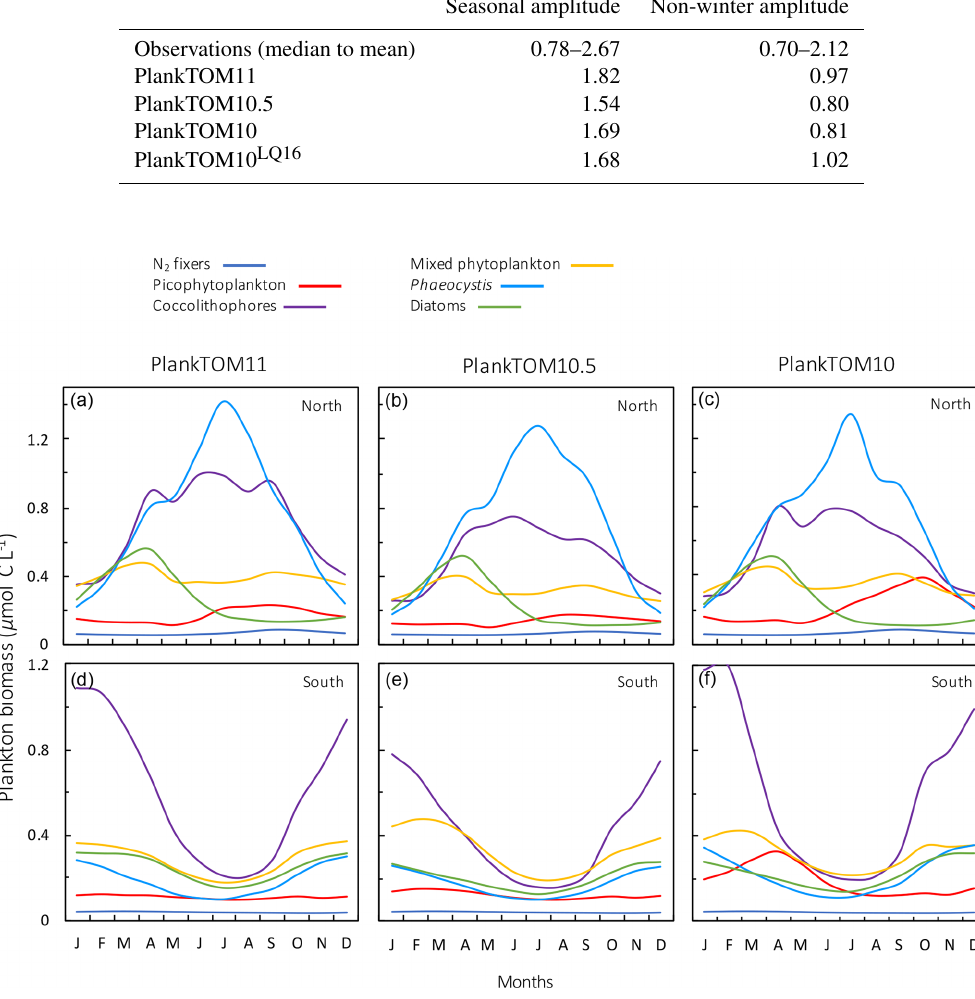
Figure A1. Seasonal surface carbon biomass (µmolCL − 1 ) of phytoplankton PFTs; N 2 fixers, picophytoplankton, coccolithophores, mixed phytoplankton, Phaeocystis and diatoms. Panels show PFT biomass for PlankTOM11 (a, d) , PlankTOM10.5 (b, e) and PlankTOM10 (c, f) for two regions; the north 30–70 ◦ N (a–c) and the south 30–70 ◦ S (d–f) across all longitudes. All data are averaged for